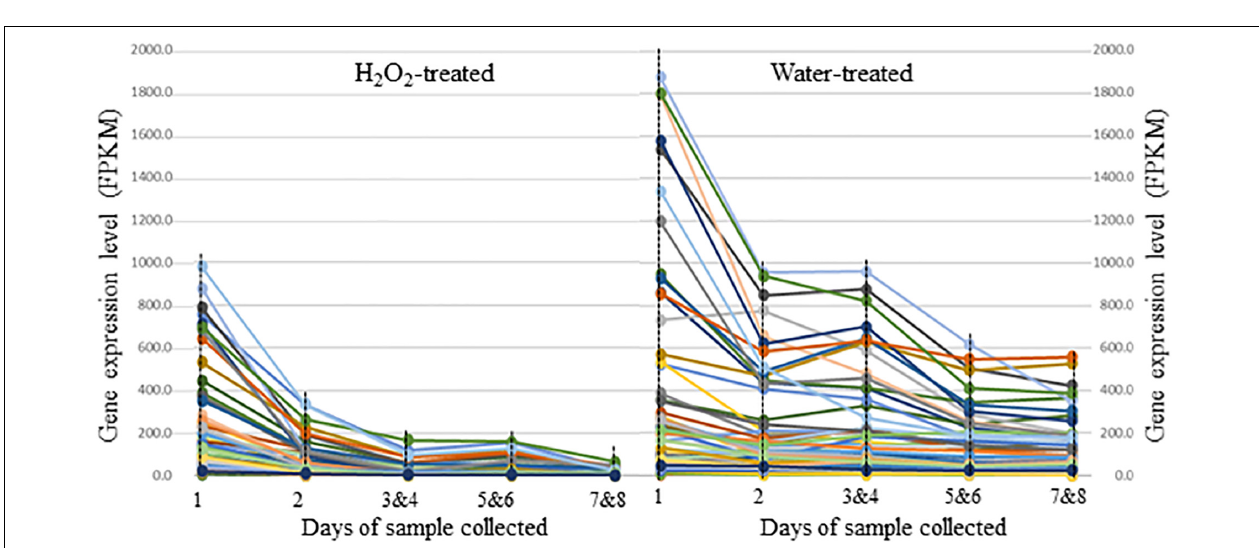
FIGURE 3 | Expression level changes for the 83 DEGs (differentially expressed genes) that were more highly expressed in seeds of sugarbeet lines F1004 and F1015 germinated in water relative to seeds germinated in H 2 O 2 . Samples labeled as 1, 2, 3&4, 5&6, and 7&8 correspond to seedball samples that were collected on the 1st, 2nd, 3rd and 4th, 5th and 6th, and 7th and 8th days. Lines with different colors represented different genes. Expression levels and function of genes were shown in Supplementary Table 2